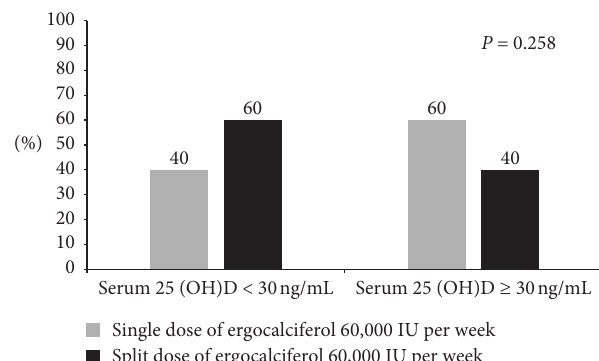
Figure 3: Serum 25-OH-D status after treatment with single and split dose ergocalciferol 60,000IU